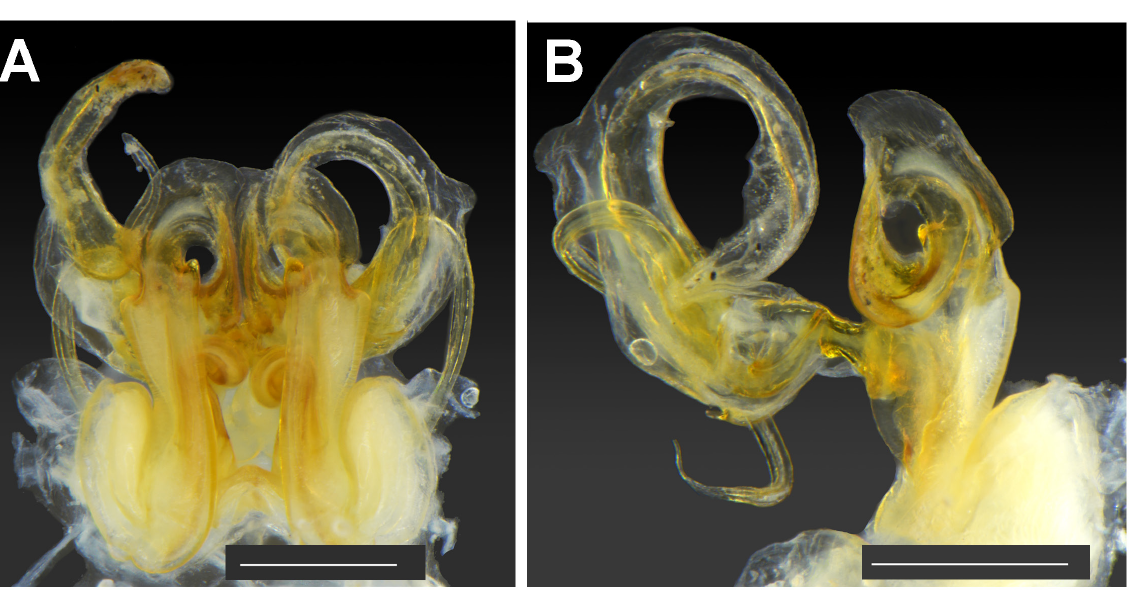
Fig. 8. Aquattuor fasciatus (Attems, 1896) comb. nov., syntype of Odontopyge fasciata (NHMW 2672). A . Gonopods, anterior view. B . Left gonopod, posterior view. Scale bars = 0.5 mm. Photographs: N.